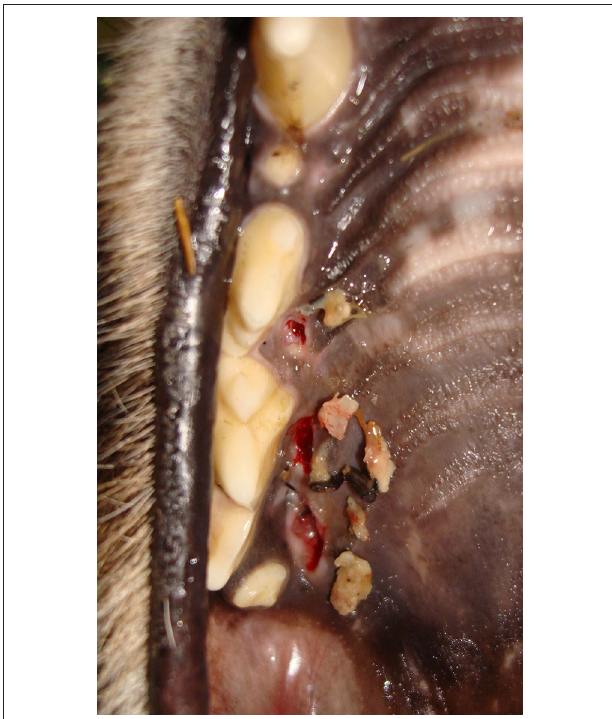
FIGURE 7 | Photograph depicting foreign material such as bone fragments that were frequently encountered in the FP lesions in the cheetahs from the Ann van Dyk Cheetah Centre